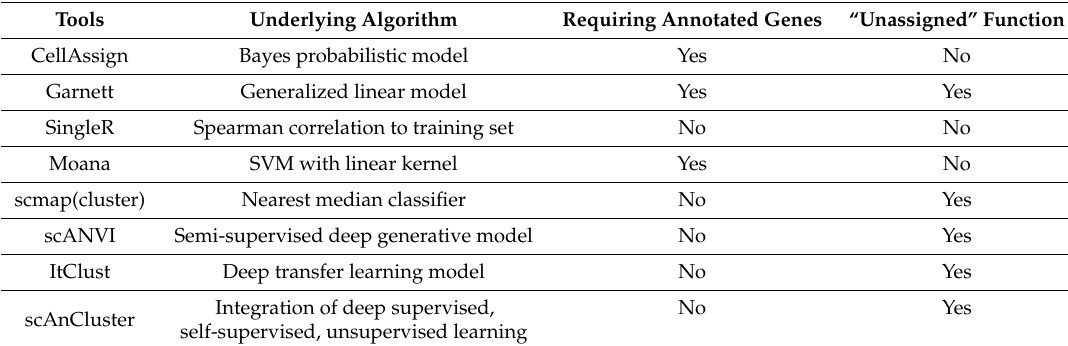
Table 1. Single-cell RNA-seq supervised annotation tools named in this